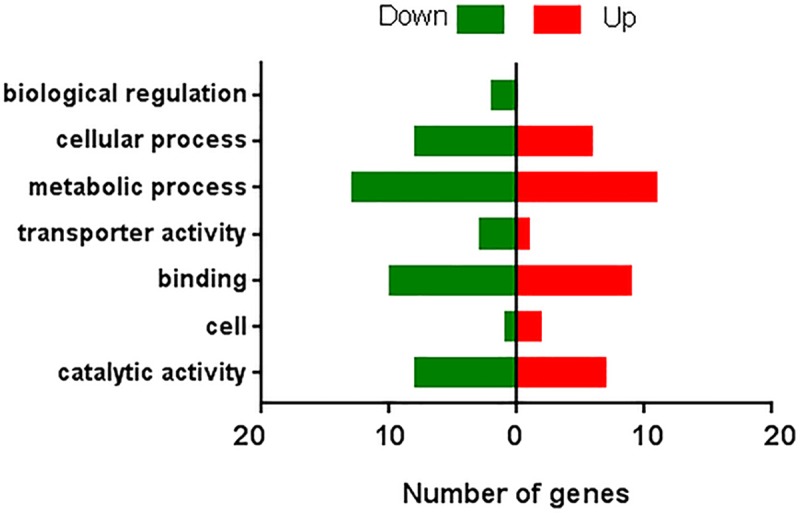
Number of differentially regulated genes in each population, grouped by gene ontology.All genes had a full length ORF with FDR less than 0.05 and logFC larger than 2 (UP) or less than -2 (DOWN). Up: Field population upregulated genes; Down: Field population downregulated genes.